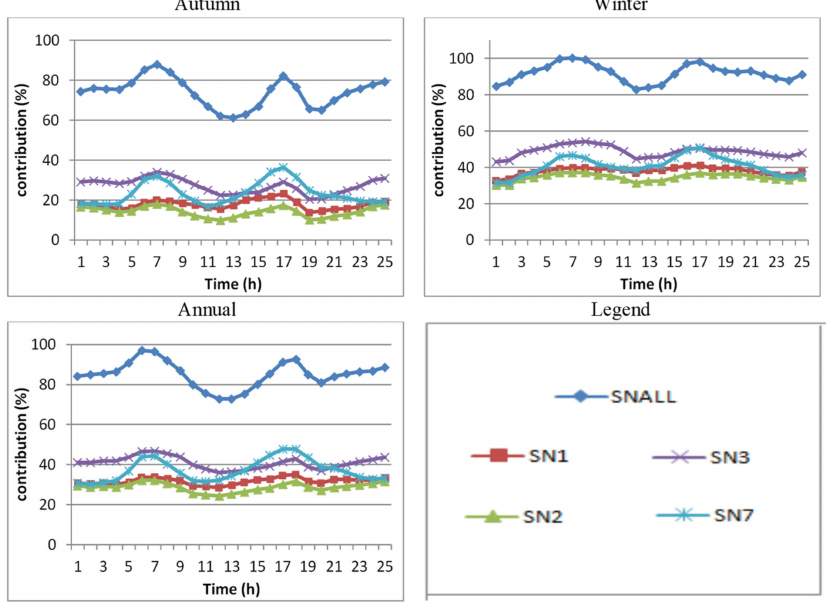
Figure 9. Annual and Seasonal averaged relative contribution (%) of all emissions and the emissions from different SNAP categories of the formation of NO 2 concentrations for Orlov most for the period 2008–2014.